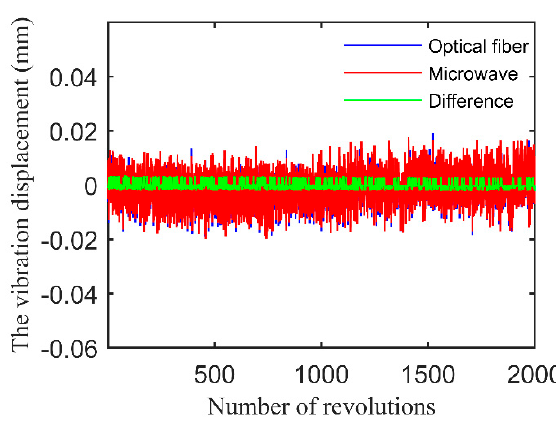
Figure 9. Vibration displacements of blade 1 obtained by the microwave sensor and the fiber optic sensor, and the differences between them, measured over 2000 revolutions.